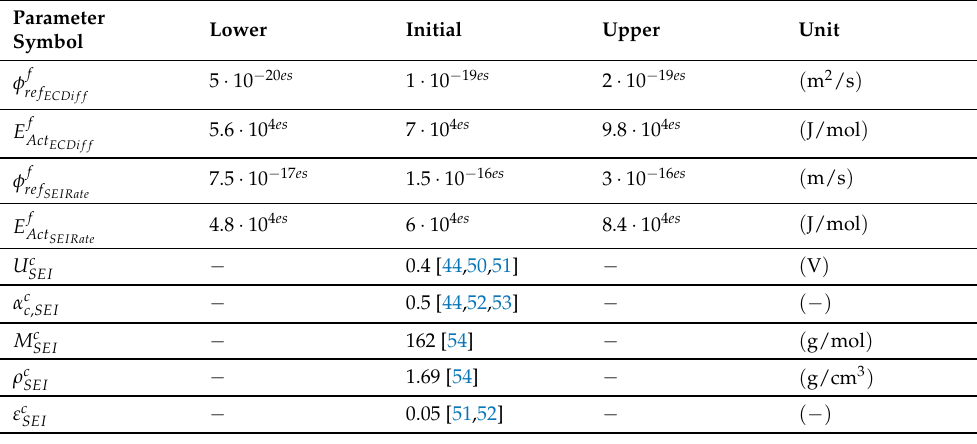
Table 6. Considered parameters of the calibrated anode SEI layer growth model at temperature 25 ◦ C. c: constant parameter; f: fitted parameter to experimental data; es: estimated value.